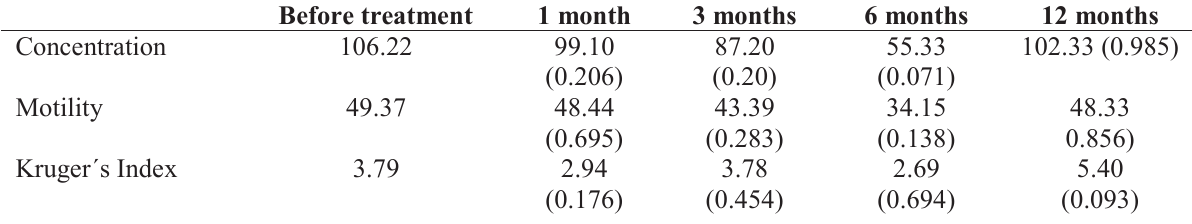
Table 1 - Concentration of spermatozoids per ml, motility and Kruger´s índex before treatment and one, three, six and twelve months after the treatment with sclerotherapy in 22 patients. Average value and p value on each occasion in comparison with those prior to treatment.